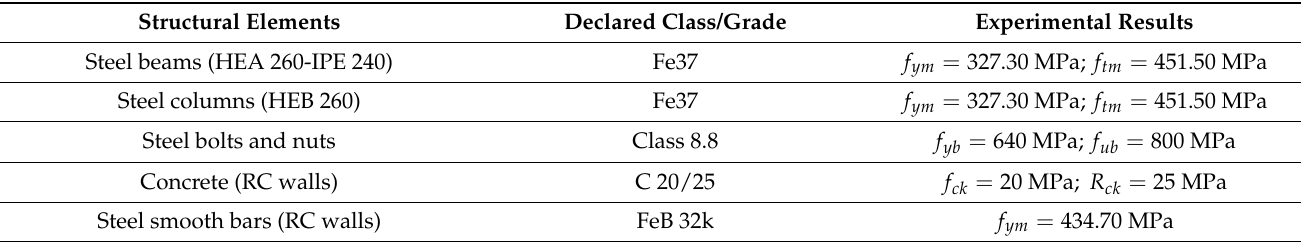
Table 2. Mechanical properties of the structural elements.